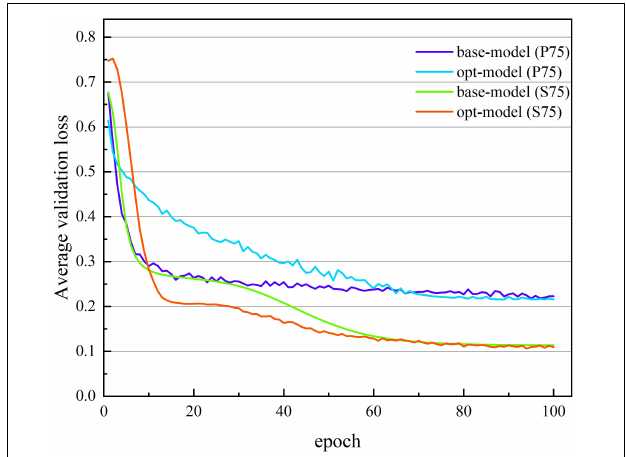
FIGURE 8 | The average verification loss curve of two network structures. The abscissa is the number of iterations, whose range of values is from 1 to 100; and the ordinate is the average verification loss rate, whose range of values is from 0.752 to 0.108.